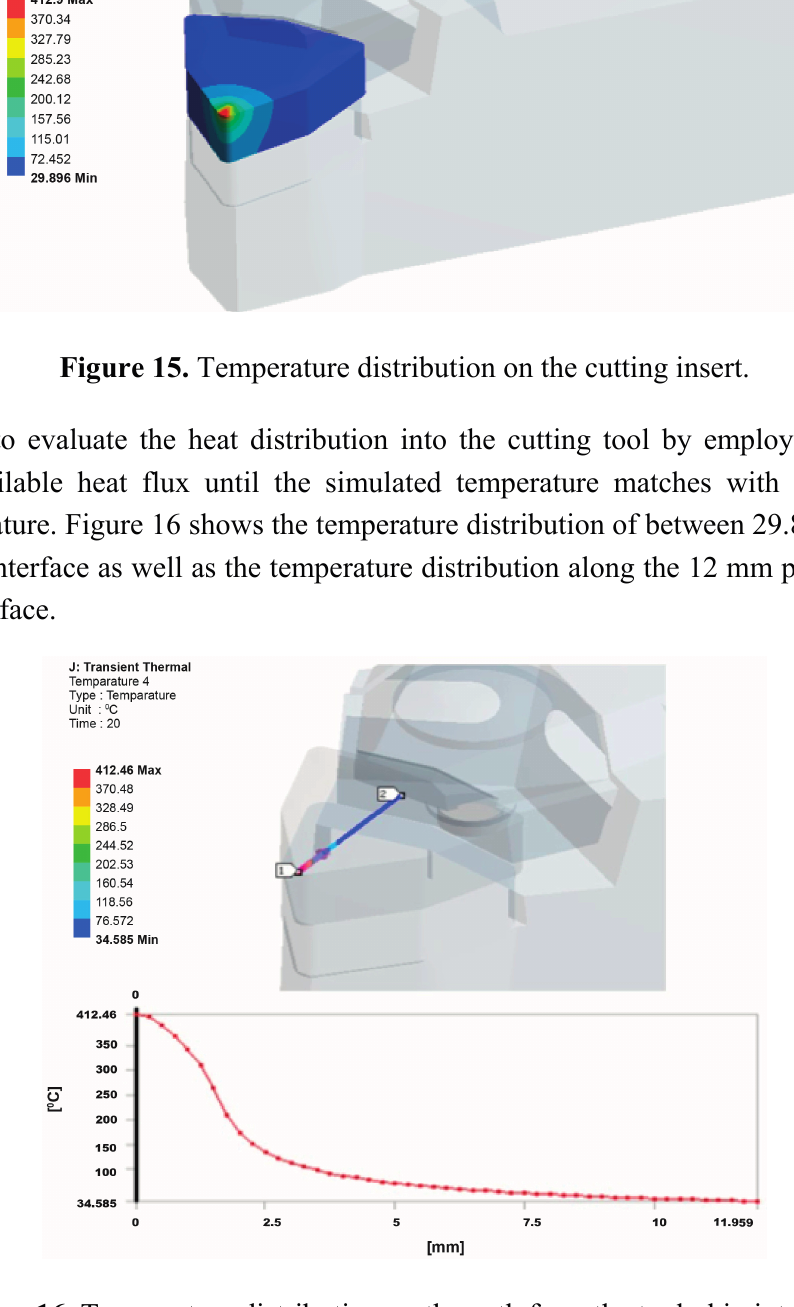
Figure 16. Temperature distribution on the path from the tool-chip